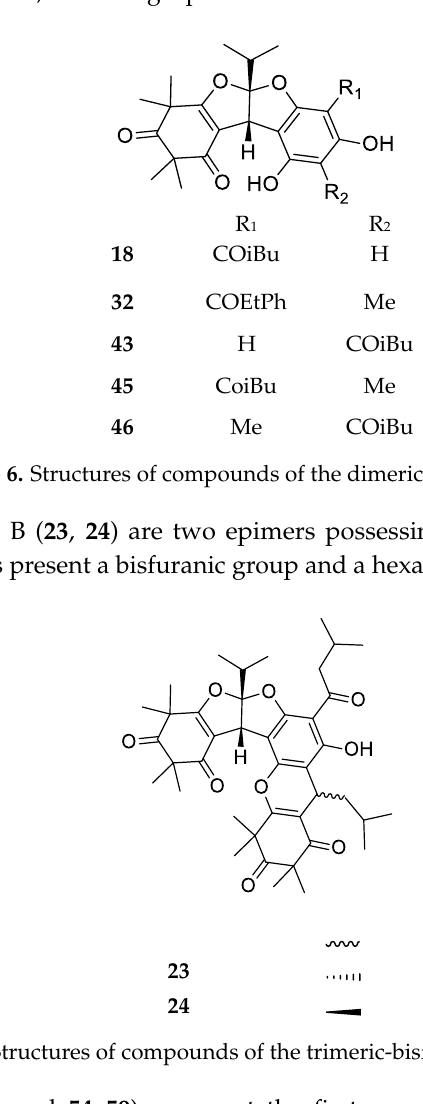
Figure 8. Structures of compounds of the terpene-adduct type. The available literature concerning Myrtaceae also reports the existence of products that are not classifiable as acylphloroglucinol oligomers, and are hence not included in this review. Particularly, monomers of either acylphloroglucinol (e.g., callisalignene A–C [25], xanchryone A–D [55], operculatol A–B [56]) or syncarpic acid (e.g., myrtucommulone K [35,57], callistiviminene A–O [58]), and flavonoids conjugated to a syncarpic acid residue (e.g., kunzeanones A–C [59], myrtocummunines A–D [51]). A huge laboratory activity has been carried out on the synthesis of phloroglucinol compounds [60]. As an answer to the rising interest for pharmaceutical applications of myrtucommulones and